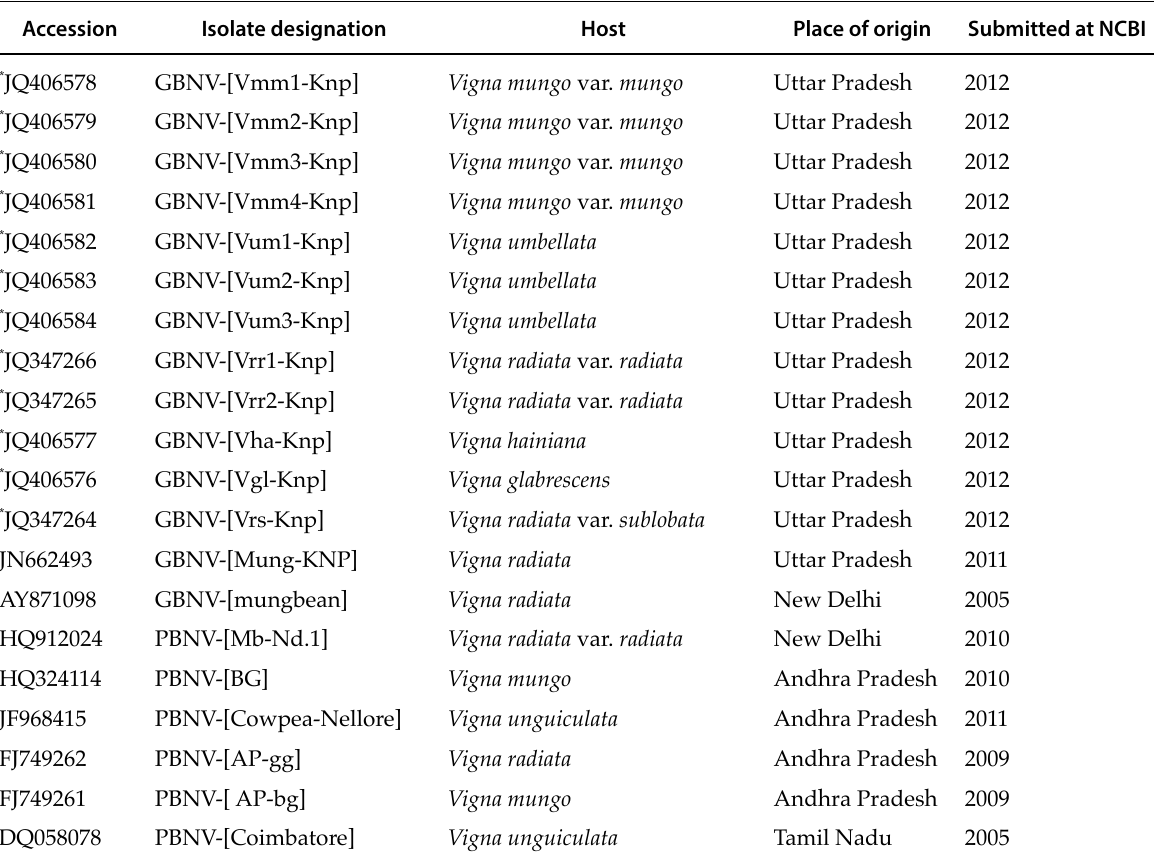
Table 1. GBNV isolates of Vigna species obtained in this study, and other isolates used for comparisons. Accession Isolate designation Host Place of